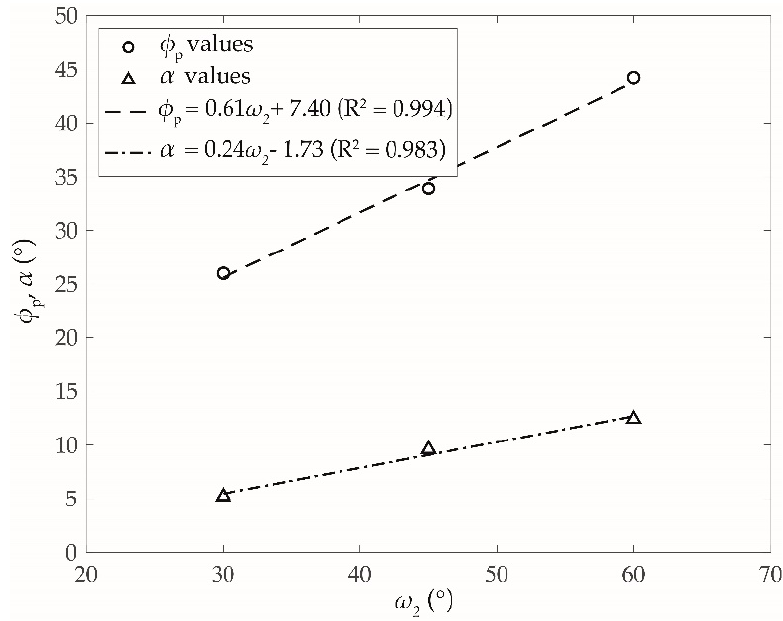
Figure 6. Linear variation of angles φ p and α as a function of slope inclination ω 2 . Spherical blocks of unitary volume and absence of forest are considered here.